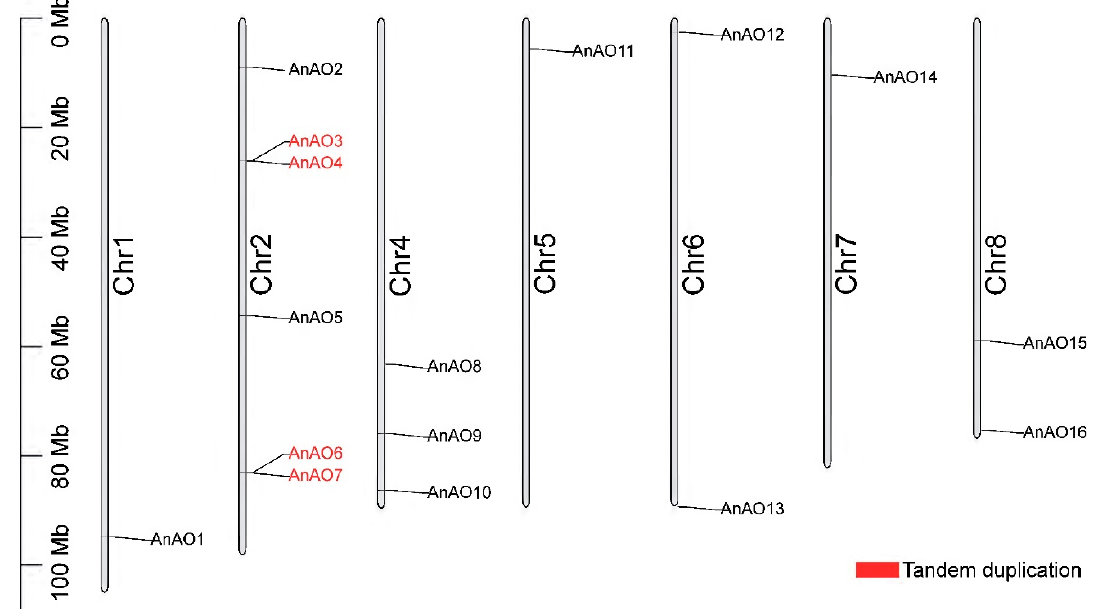
Figure 1. The distribution of AnAO genes in the chromosomes of A. nanus . Represented as tandem duplication. dem